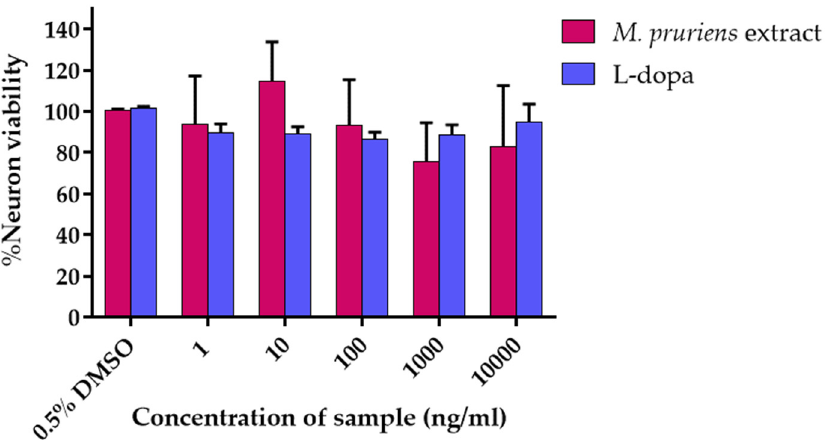
Figure 1. P19-derived neurons cell viability in various concentration (1–10,000 ng/mL) of Mucuna pruriens seed aqueous extract and L-dopa.